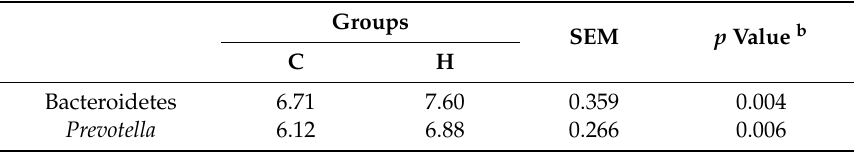
Table 3. Influence of di ff erent nutrient density in the diets on the number of bacteria a .